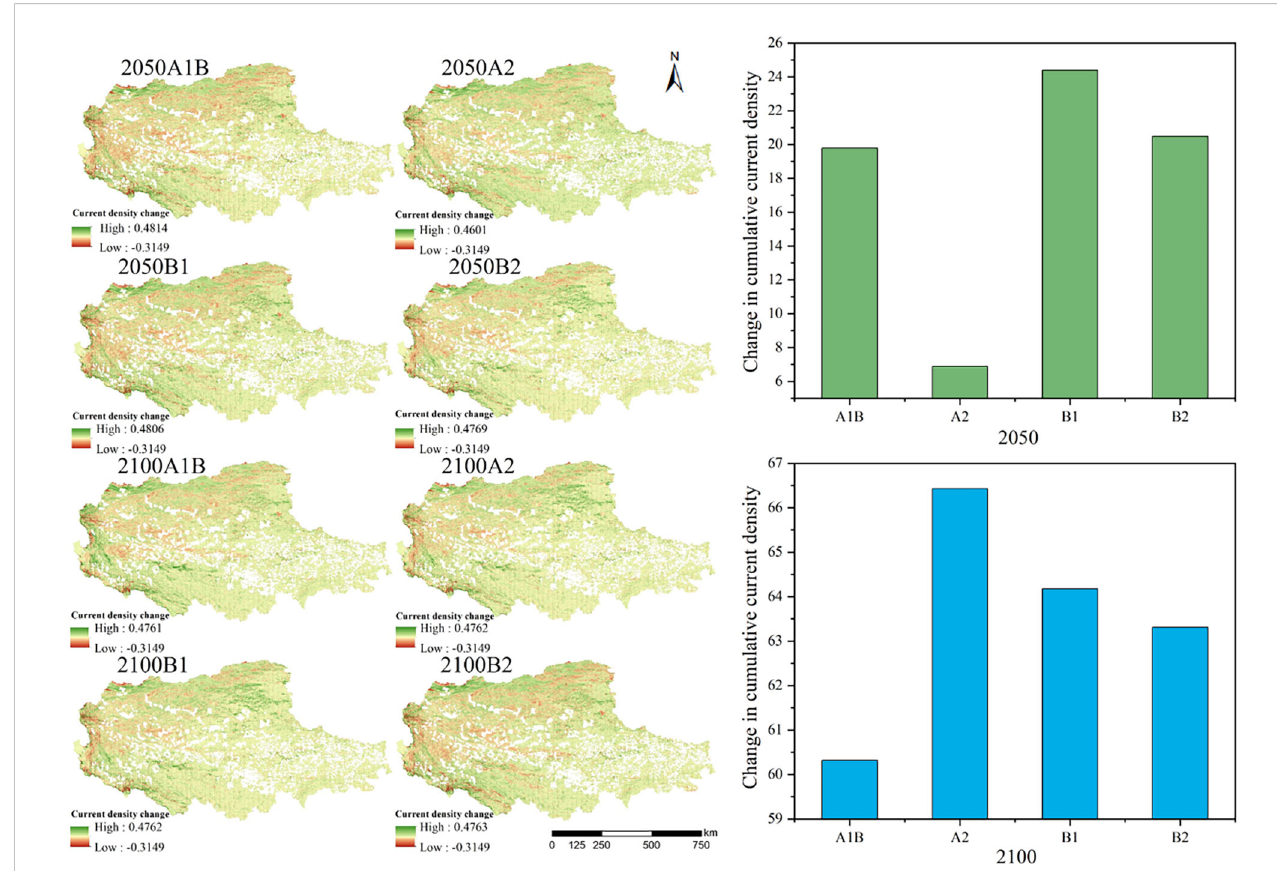
FIGURE 10 Cumulative current density changes under different future scenarios in the northern Tibetan